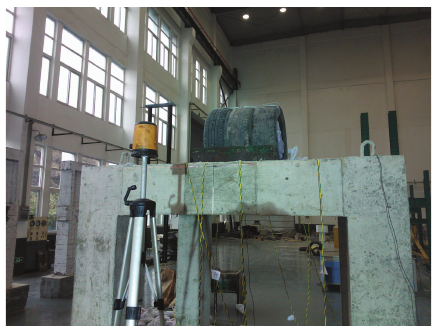
Figure 4: Used tire cushion layer for